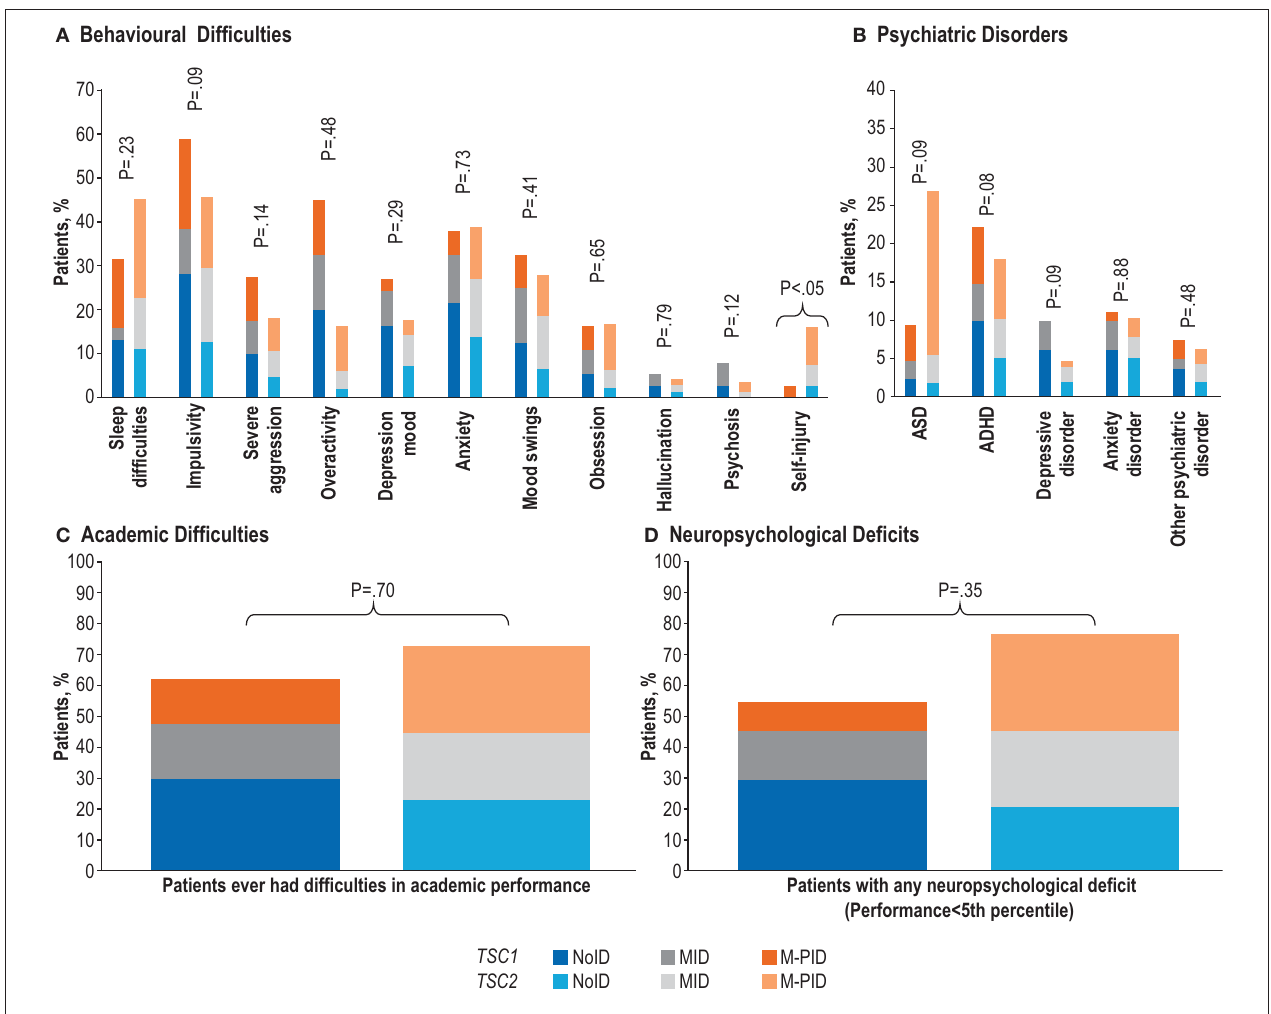
FIGURE 3 | Frequency of TAND features stratified by levels of intellectual ability (noID [IQ > 70], MID [IQ 50–70] and M-PID [IQ < 50]) in TSC1 vs. TSC2 . (A) Behavioral difficulties. (B) Psychiatric disorders. (C) Academic difficulties. (D) Neuropsychological deficits. Percentages calculated excluding missing/unknown data.